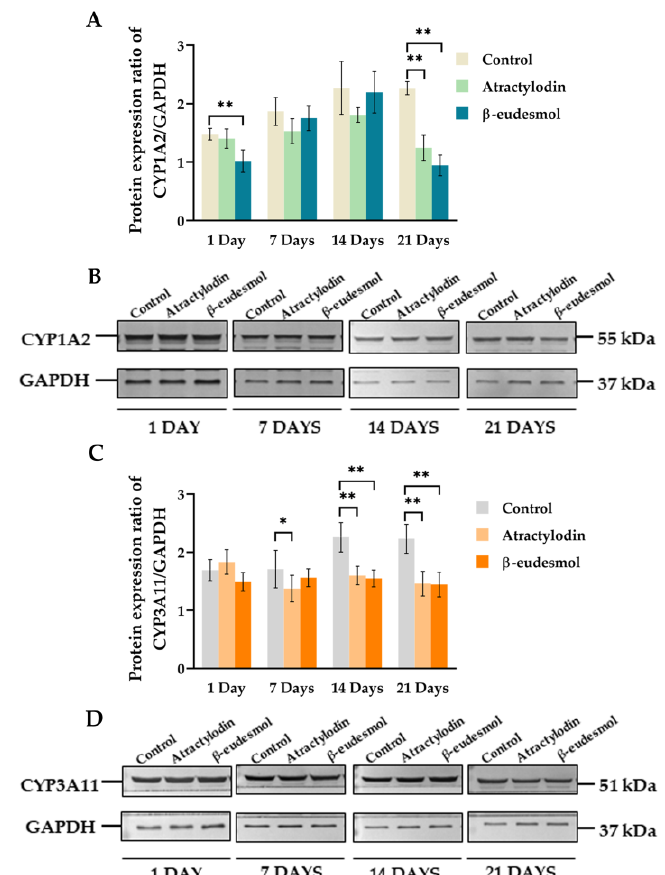
Figure 2. Protein expression ratio and western immunoblots analyses of mCYP1A2 and mCYP3A11 in mouse livers. The protein expression ratio and analysis of western immunoblots of mCYP1A2 ( A , B ) and mCYP3A11 ( C , D ) were investigated in the polled livers of three male ICR mice following a daily oral dose of 100 mg/kg body weight of atractylodin, or β -eudesmol for 1, 7, 14, and 21 days. Control mice were fed with distilled water. Data are expressed as median (95% CI) from six replications. Asterisks indicate significant differences from the control. Statistical significance with * p = 0.039, ** p = 0.004 compared with control.